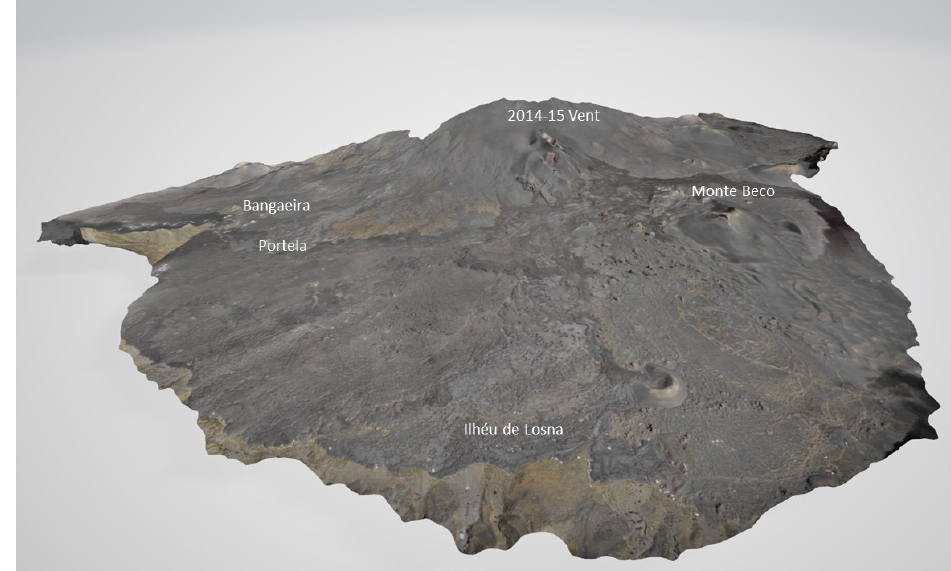
Figure 17. A 3D visualization of the texture mesh of the Chã das Caldeiras from Ilhéu de Losna towards the east.